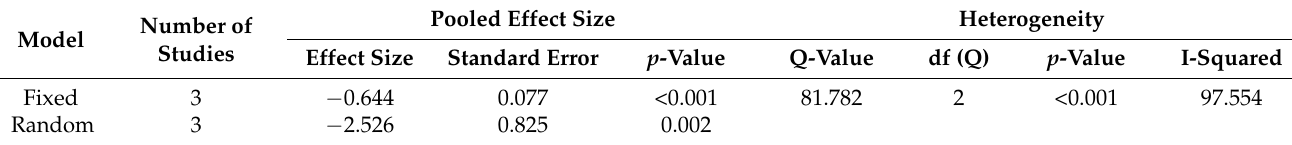
Table 9. Heterogeneity test results of studies on the influence of indoor plants on DBP.